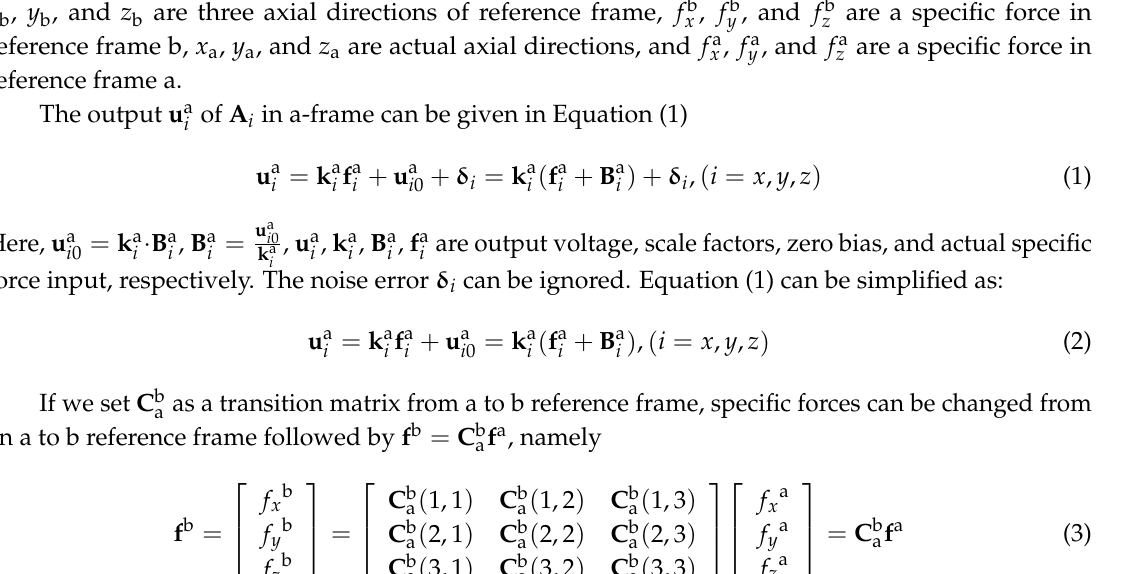
Figure 1 represents the hexahedral reference orthogonal coordinate system O b x b y b z b of MIMU, and the non-orthogonal coordinate system, which is the actual measuring direction for accelerometers. For simplicity, O b and O a are set at the same point